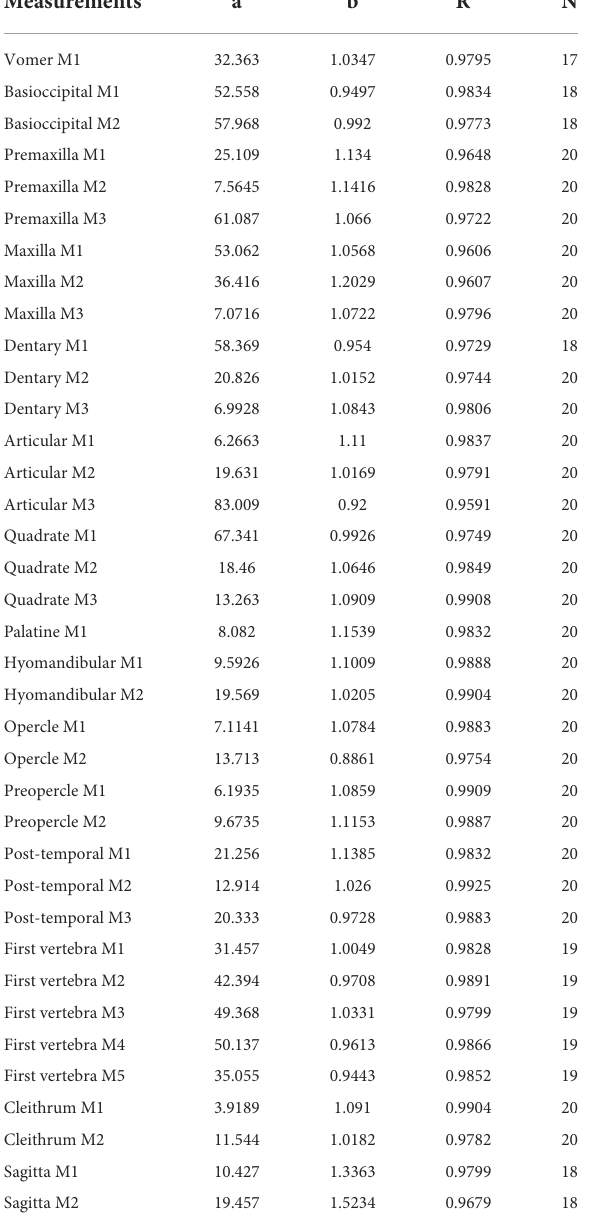
TABLE 3 Regression formula parameters for estimating the total length of Chinese sea bass ( Lateolabrax maculatus ) from bone measurements (in mm).